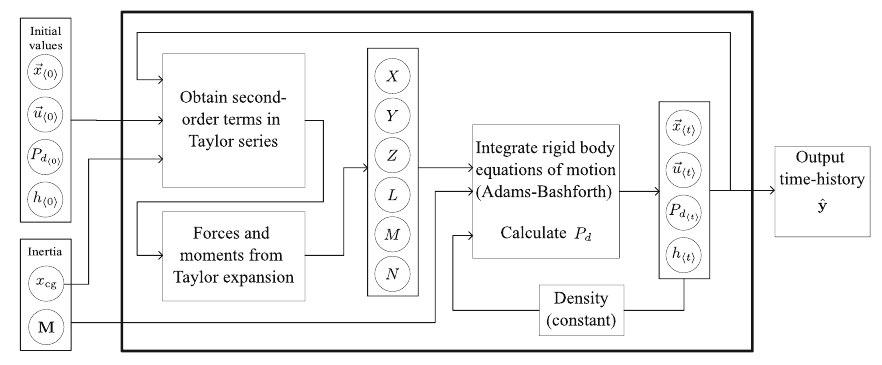
Fig. 1 Flow chart of